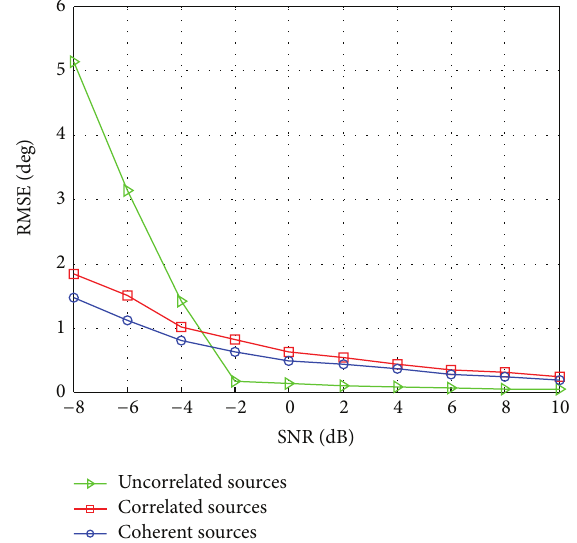
Figure 8: RMSE of the proposed method versus input snapshots for the uncorrelated, correlated, and coherent signals.